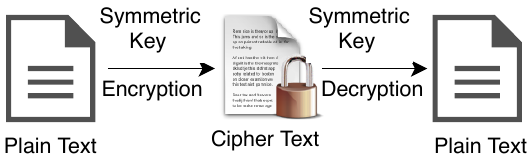
Figure 6. Symmetric Key Encryption.